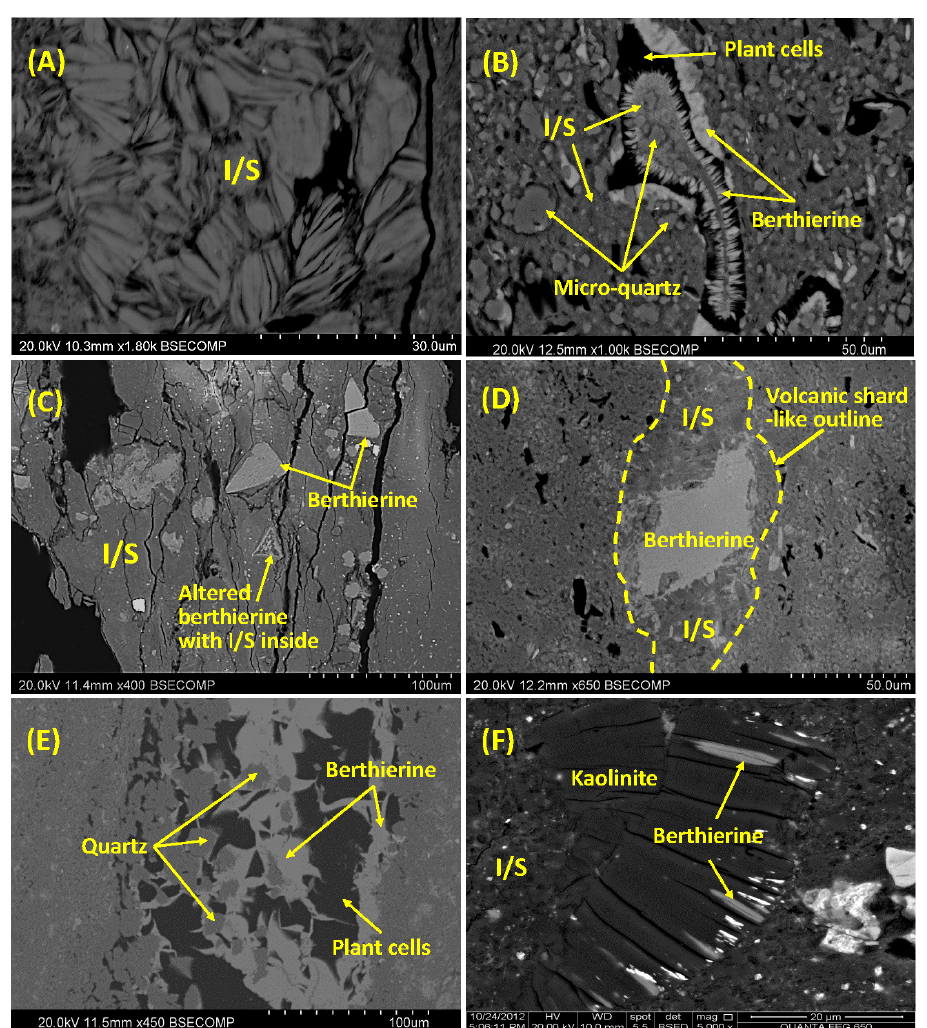
Figure 6. Back-scattered electron images of clay minerals. ( A ) Authigenic lath-like I/S (X-2); ( B ) Berthierine and I/S within plant cell (black areas), and micro-quartz particles (X-1); ( C ) Berthierine particles (X-2); ( D ) I/S surrounding berthierine (L-18); ( E ) Quartz coexisting with berthierine within plant cells (L-5); ( F ) berthierine within fractures of vermicular kaolinite